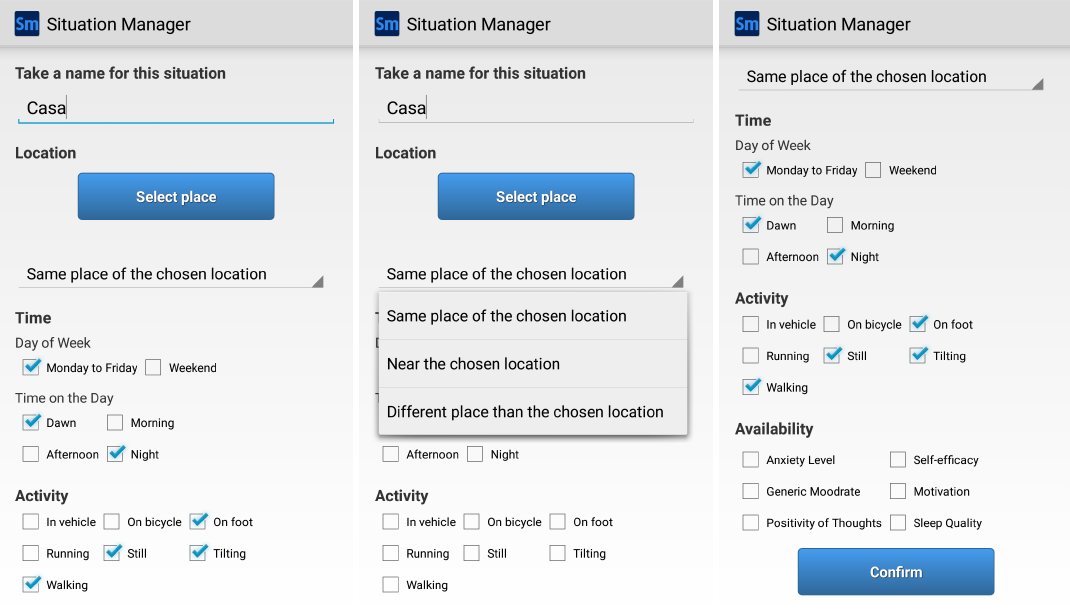
Figure 7. SituMan mobile GUI for defining